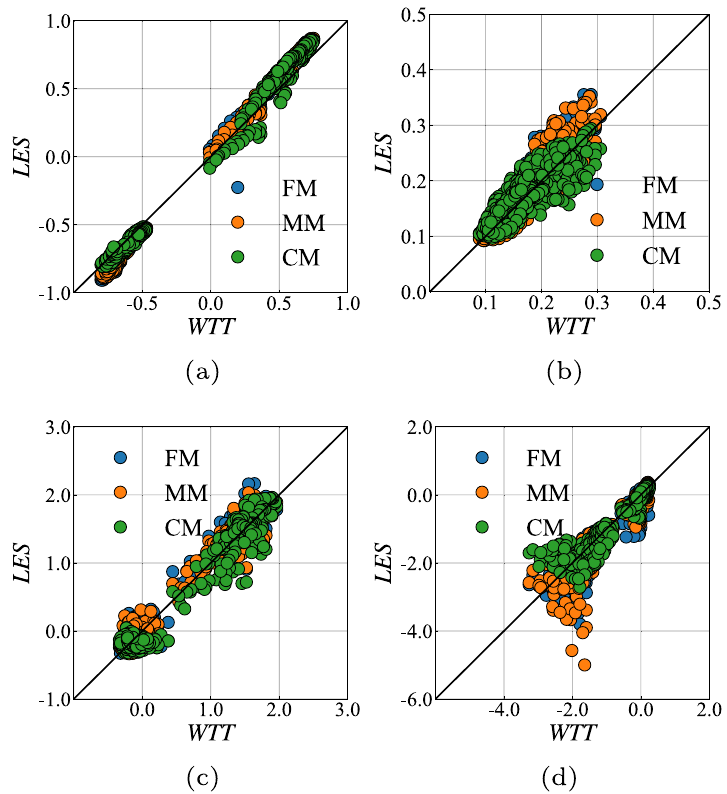
Fig. 5 Comparisons of LES results using different mesh resolutions with WTT: ( a ) ¯ C p , ( b ) C ′ p , ( c ) ˆ C p and ( d ) ˇ C